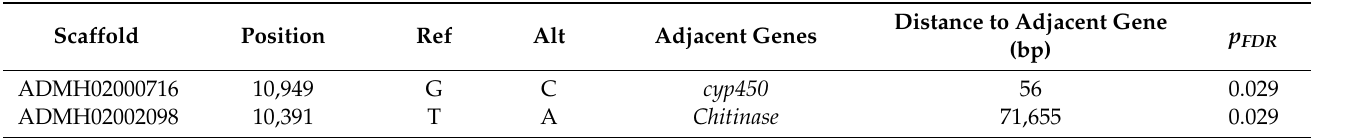
Table 2. List of statistically significant markers ( p FDR < 0.05) and adjacent genes in GWAS for Plasmodium infection. Adjacent genes located in a maximum range of 80 kb are